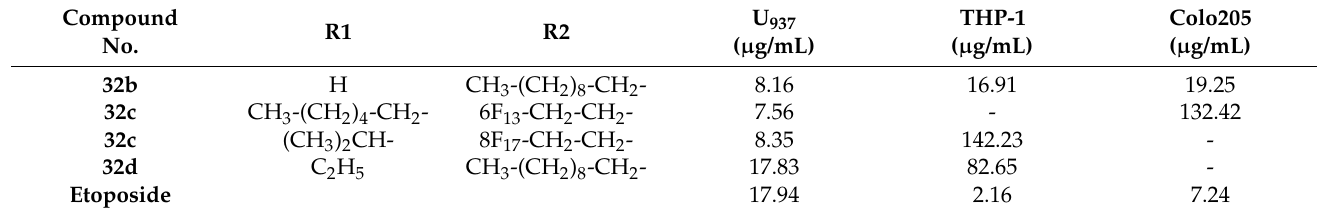
Figure 35. Structure of pyrimidine ‐ triazole based hybrids and the most promising compound 32a. Table 25. In vitro cytotoxic activities of pyrimidine ‐ triazole hybrid compounds 32 ( b – e ). Compound